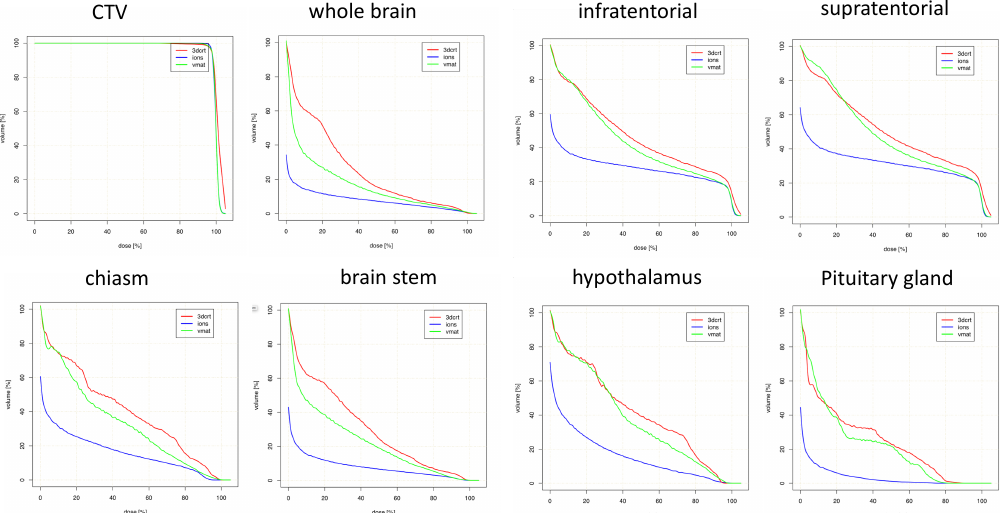
Figure 4. Dosimetric comparison: clinical target volume coverage and dose volume histogram curves of the organs-at-risk in patients with parietal tumor localization. Curves demonstrate median dose values of all patients with temporal tumor localization. Intensity-modulated proton therapy (IMPT/PRT; blue line) vs. volumetric-modulated arc therapy (VMAT; green line) vs. three-dimensional conformal radiotherapy (3DCRT; red line). CTV: clinical target